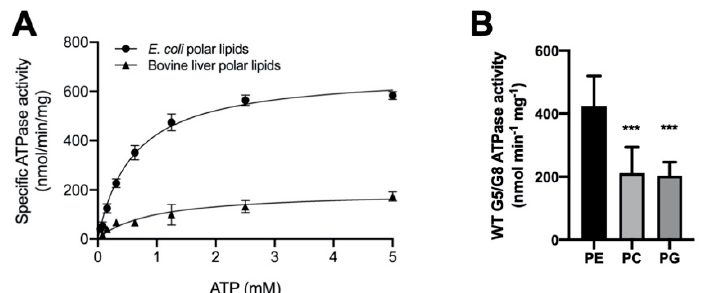
Figure 4. Lipid dependence of ABCG5 / G8 ATPase activity. ( A ) Purified ABCG5 / G8 was assayed in the presence of either Escherichia coli or bovine liver polar lipids, and the specific activities of ATP hydrolysis were obtained by the ATP concentration-dependent experiments (0–5 mM ATP). Both curves are fitted to the Michaelis–Menten equation (Prism 8), and, using two independently purified proteins, the means of at least three independent experiments along with standard deviations are plotted here. The kinetic parameters are listed in Table 1. ( B ) In conditions of 5 mM ATP and 4.1 mM CHS, ATP hydrolysis of purified ABCG5 / G8 was assayed in the presence of egg phosphatidylethanolamine (PE), soy phosphatidylcholine (PC), or egg phosphatidylglycerol (PG), where p -values of 0.0006 and 0.0003 (marked as ***), respectively, were obtained using ordinary one-way ANOVA (Prism 8). Table 1. Dependence of ABCG5 / G8 ATPase activity on ATP.